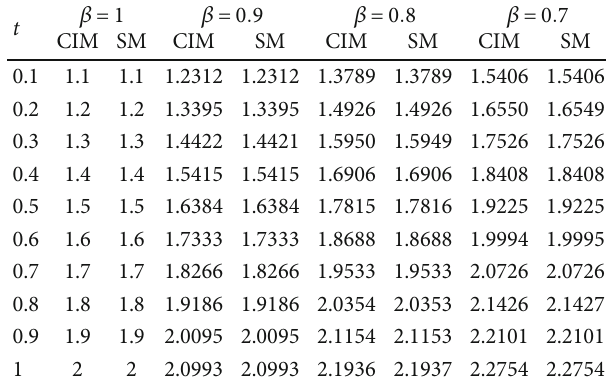
Table 6: The approximate solutions of ζ for various values of β 1 using the two numerical schemes N = 240, M = 20 , corresponding to Problem 4.